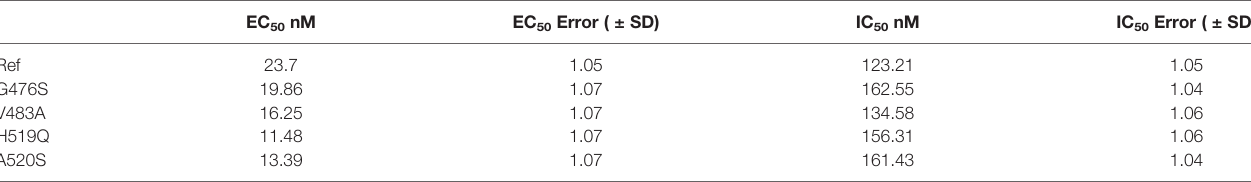
TABLE 3 | ELISA binding pro fi les of S-RBD reference/mutants and